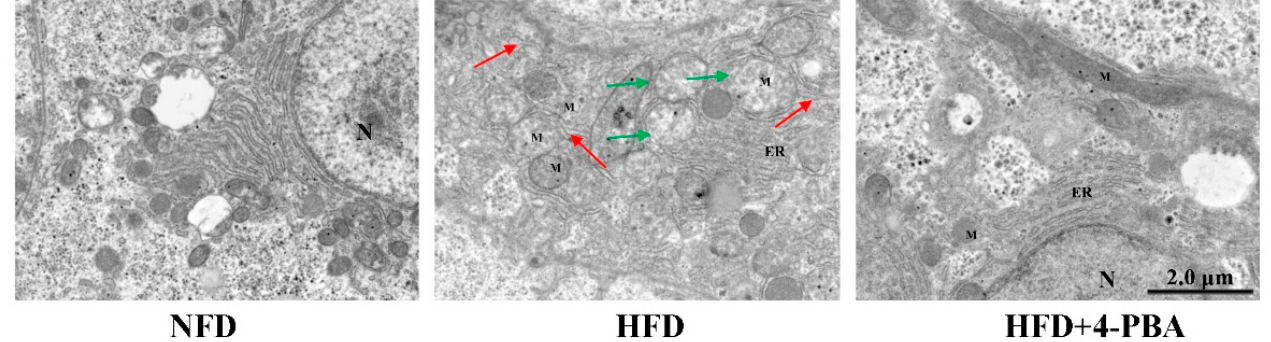
Figure 5. Hepatic transmission electron microscopy (TEM) images of L. maculatus that were fed the test diets for eight weeks. (N—nucleus; M—mitochondrion; green arrows—damaged mitochondria; red arrows—damaged endoplasmic reticulum).